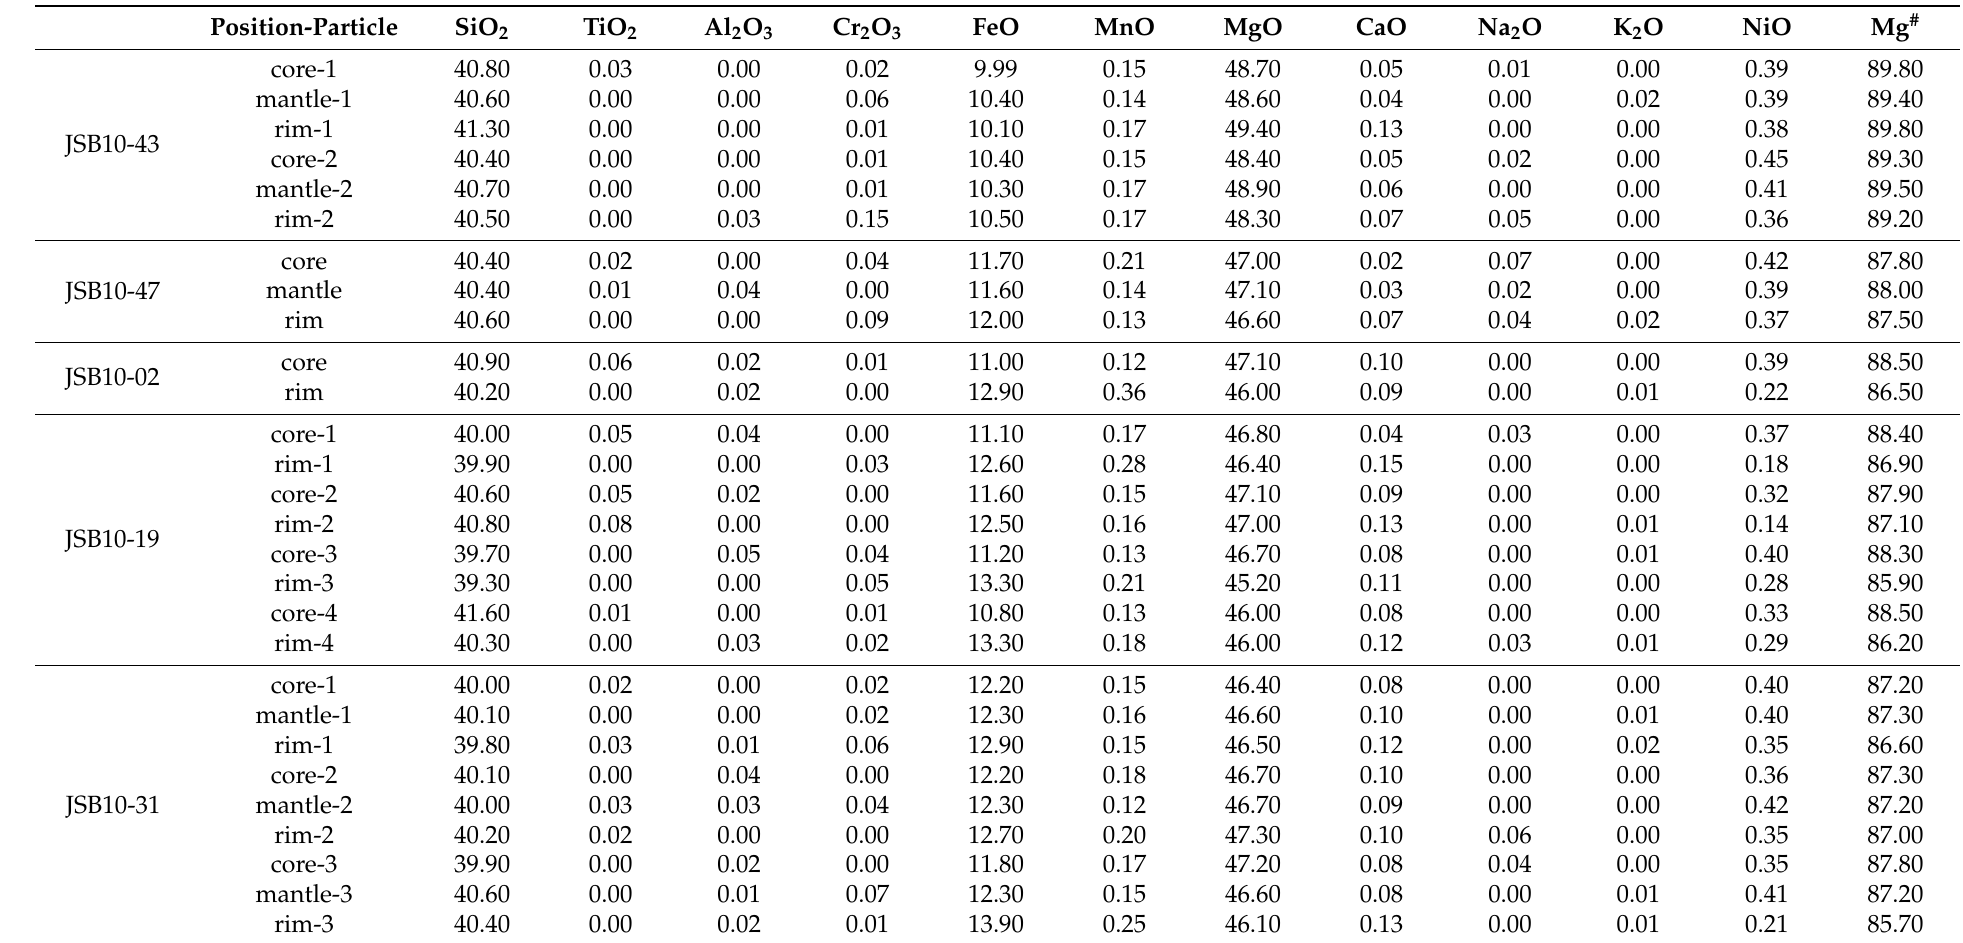
Table 4. The major element composition of olivine (Ol) in the websterite determined by